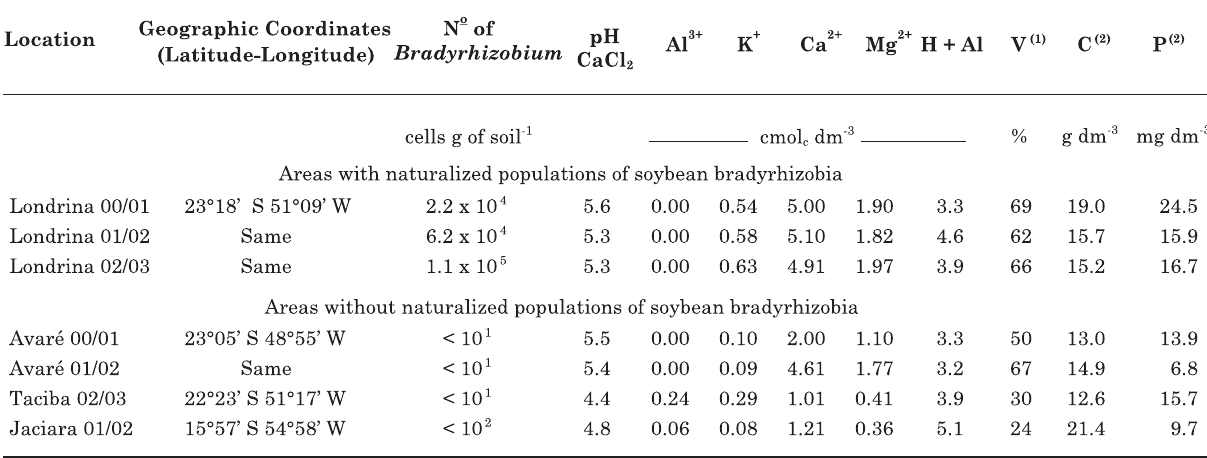
Table 1. Geographic coordinates, populations of soybean/ Bradyrhizobium , and chemical characteristics of the soils at the experimental sites in